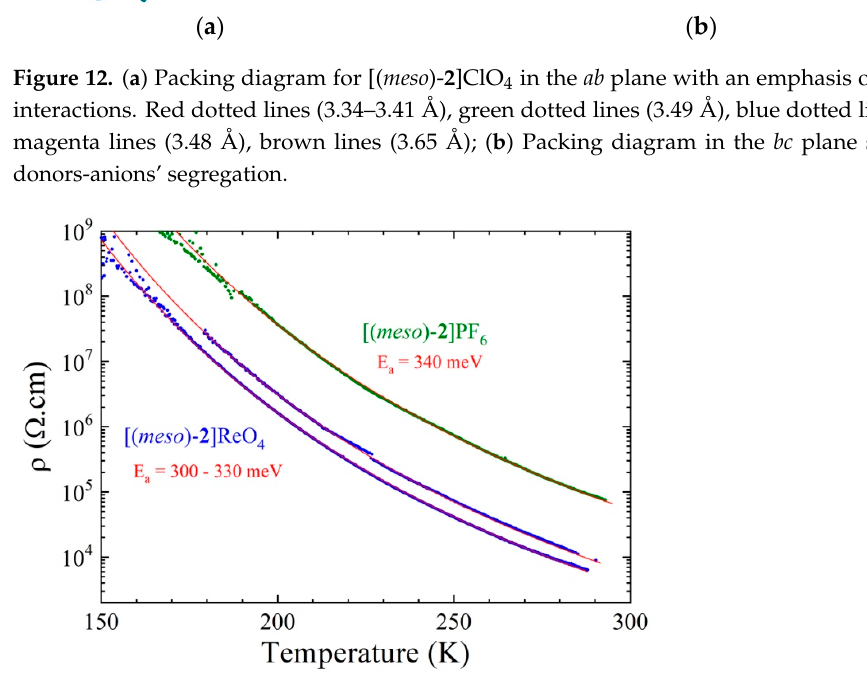
Figure 13. Temperature dependence of the electrical resistivity ρ for one single crystal of [( meso )- 2 ]PF 6